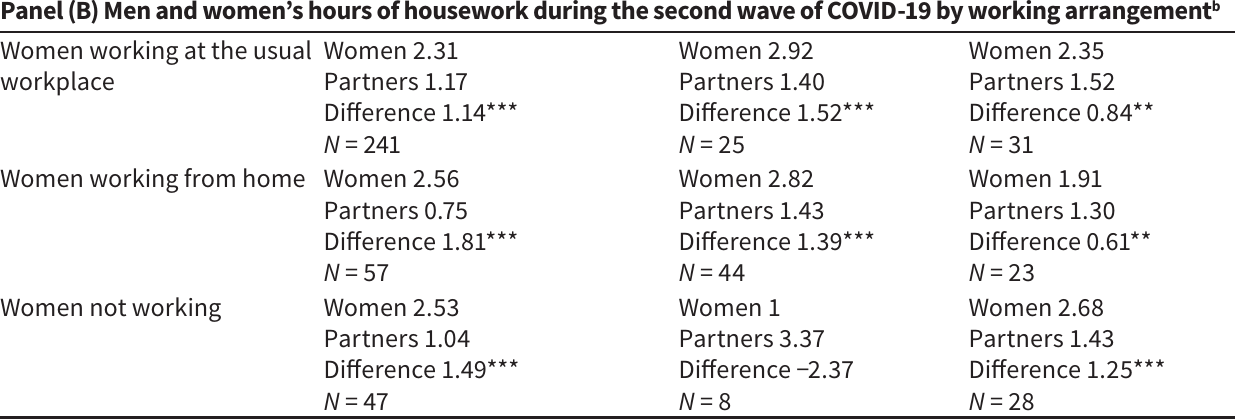
Panel (B) Men and women’s hours of housework during the second wave of COVID-19 by working arrangement b